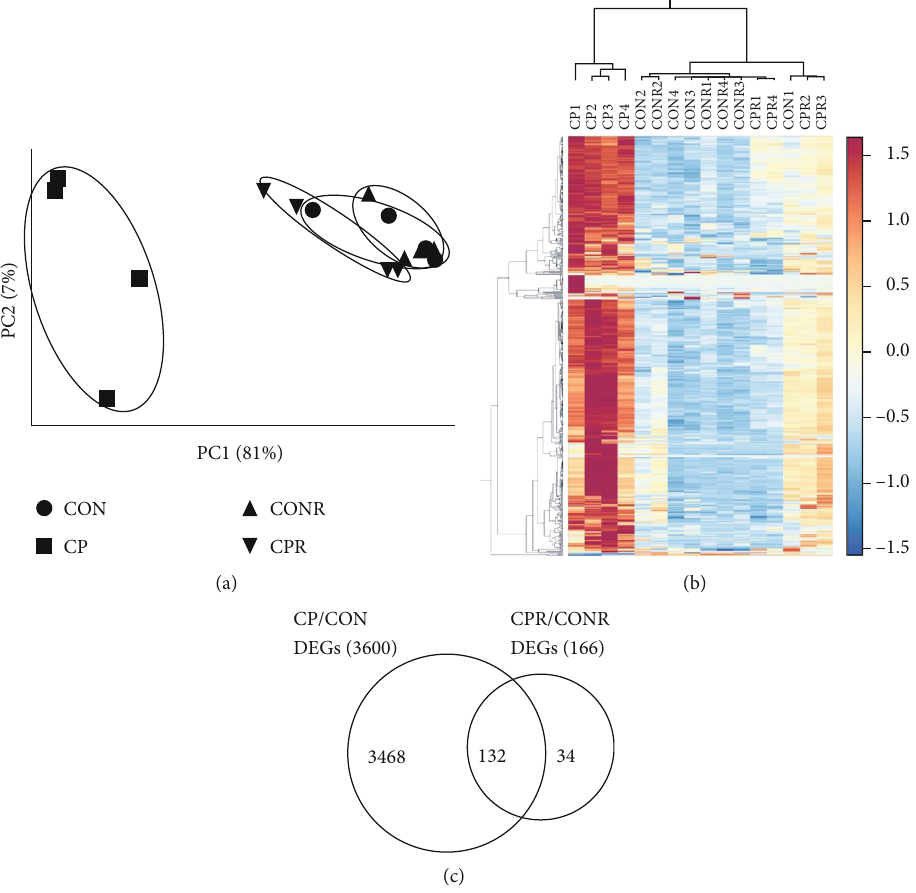
Figure 2: RNA-seq data analysis for the CON, CP, CONR, and CPR groups. Total RNAs were prepared from the mouse pancreata as mentioned in Figure 1, and RNA-seq was performed. (a) Principal component analysis (PCA) illustrates the variance of all genes expressed within each sample and among the groups. (b) The heatmap demonstrates the expression level of the DEGs among samples. Each column is a sample, and each row is a gene. The value is the z -score of normalized gene expression counts. For any given gene, the red color represents gene expression that is greater than the overall mean, and the blue color represents gene expression that is less than the overall mean. Hierarchical clustering of genes and samples is represented by the dendrograms on the left and across the top of the heatmap. For the CP and CPR groups, each could cluster as a unique group. (c) The Venn diagram depicts the distribution of the DEGs. The statistical criteria for a gene to be considered di ff erentially expressed were a fold change of Log 2 > 1 and false discovery rate ð FDR Þ < 0 : 05